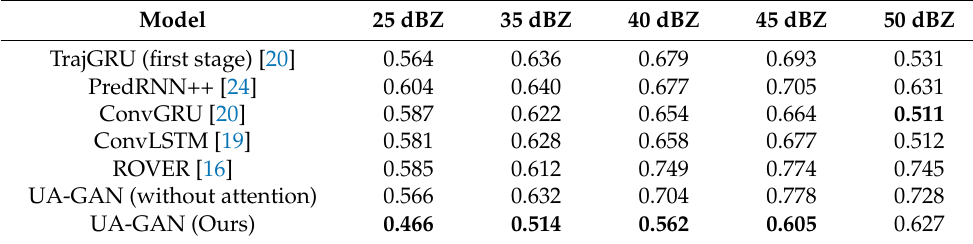
Table 12. Scores of FAR( ↓ ) at echo thresholds = 25, 35, 40, 45, and 50 dBZ.